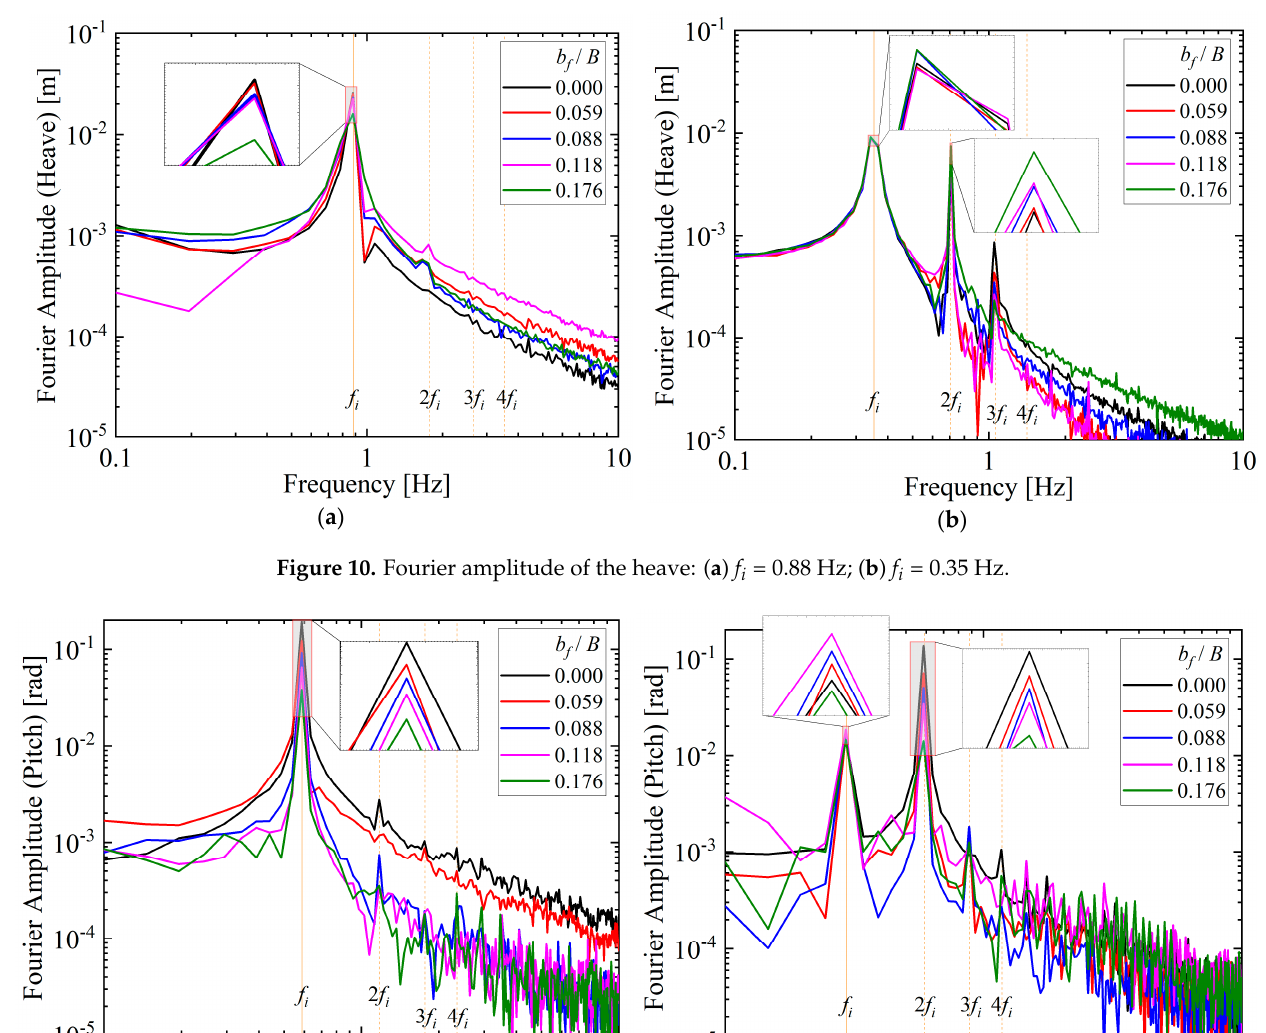
Figure 11. Fourier amplitude of the pitch: ( a ) f i = 0.59 Hz; ( b ) f i = 0.29